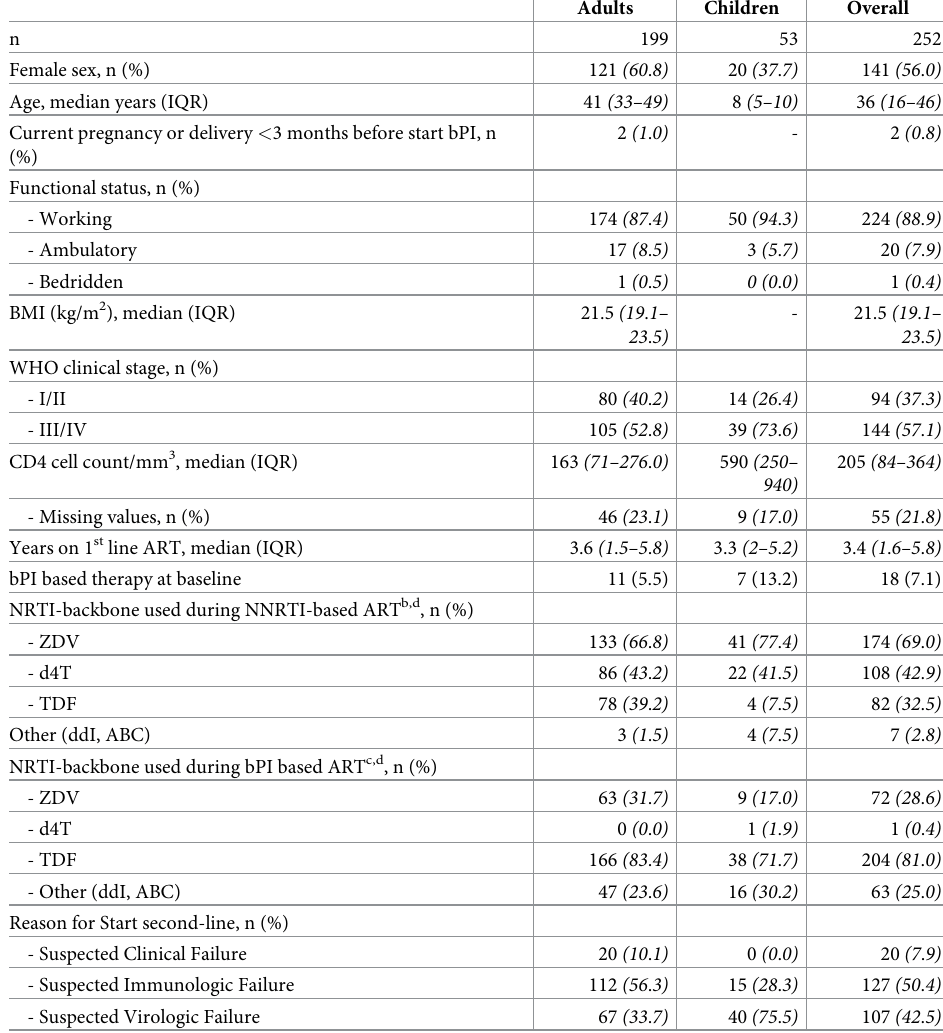
Table 1. Patient’s characteristics at start of a boosted protease inhibitor a